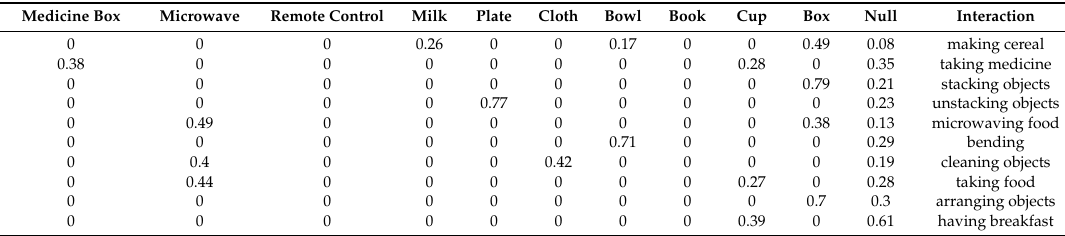
Table 5. Object usage probability (OUP) sample data for ten actions in the CAD-120 dataset. Medicine